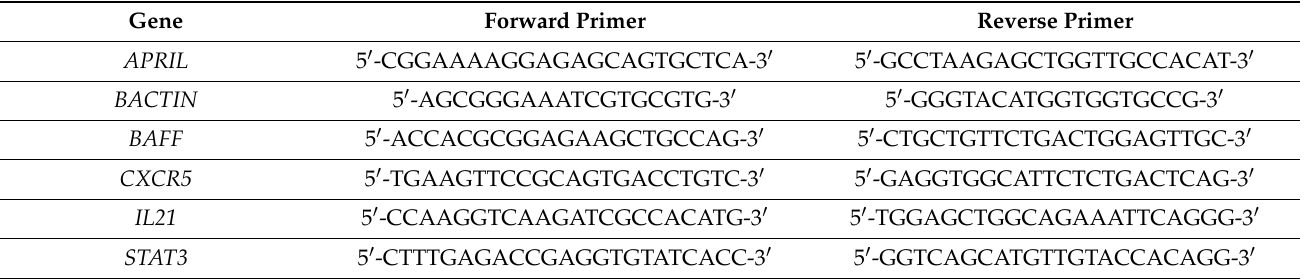
Table 2. Overview of used primers for